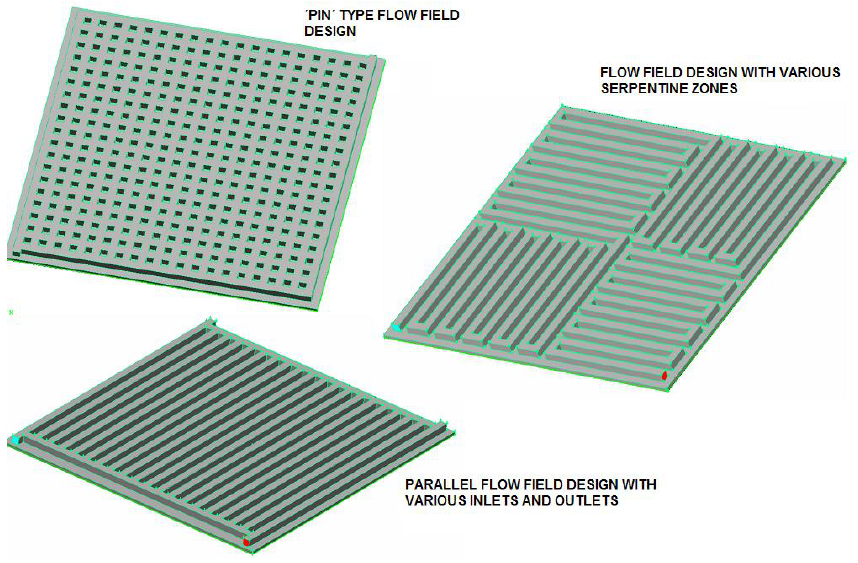
Figure 6. Different flow field designs studied in the sensitivity analysis.